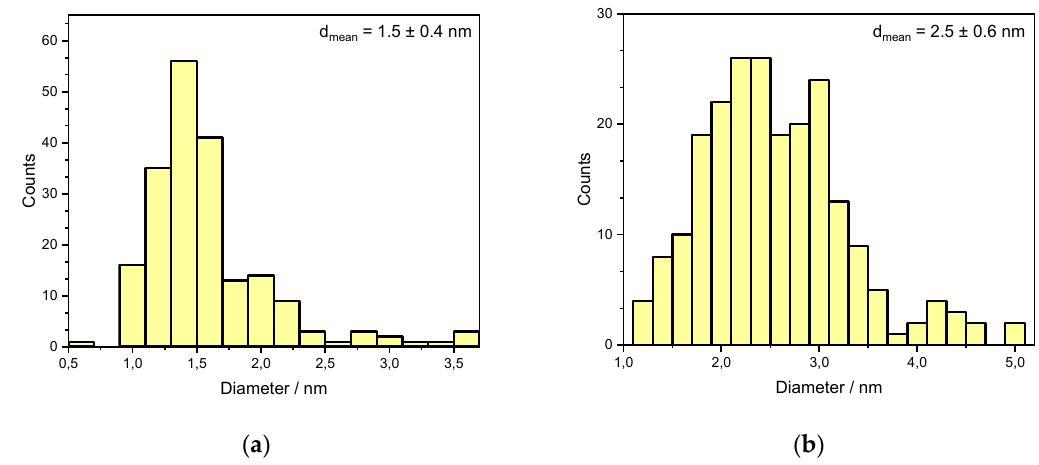
Figure 3. TEM images of a freshly prepared PdO/Al 2 O 3 catalyst sample ( a ) and of an aged PdO/Al 2 O 3 catalyst sample after 35 h at 823 K in 3200 ppm CH 4 , 15% H 2 O, 10% O 2 in N 2 ( b ).